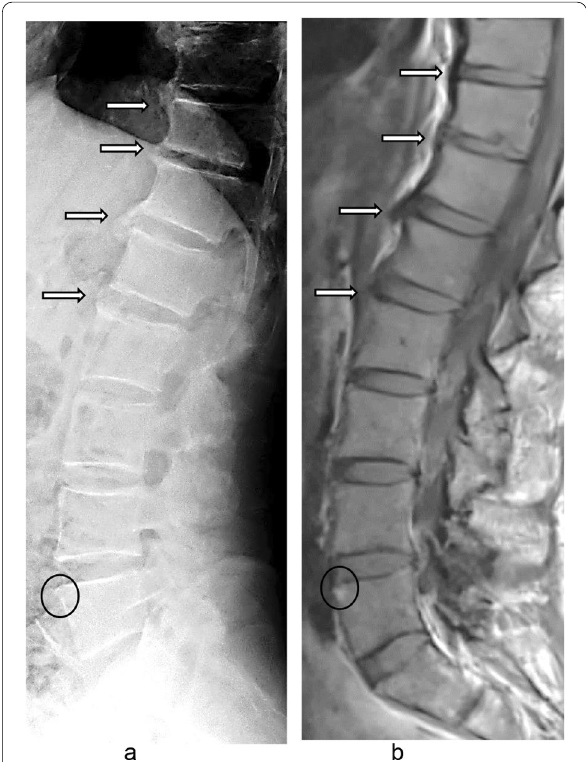
Fig. 2 Radiography ( a ) and T1-weighted MRI ( b ) of the lower thoracic and lumbar spine. Images in the sagittal plane in the same patient (male, 53 years old) diagnosed with axial SpA. The extent of osseous chronic changes at the anterior vertebral corners is depicted in more detail with radiography than with MRI (white arrows), while a presumed disease-related fatty transformation at the ventral vertebral corner of L5 is only appreciated with MRI (black